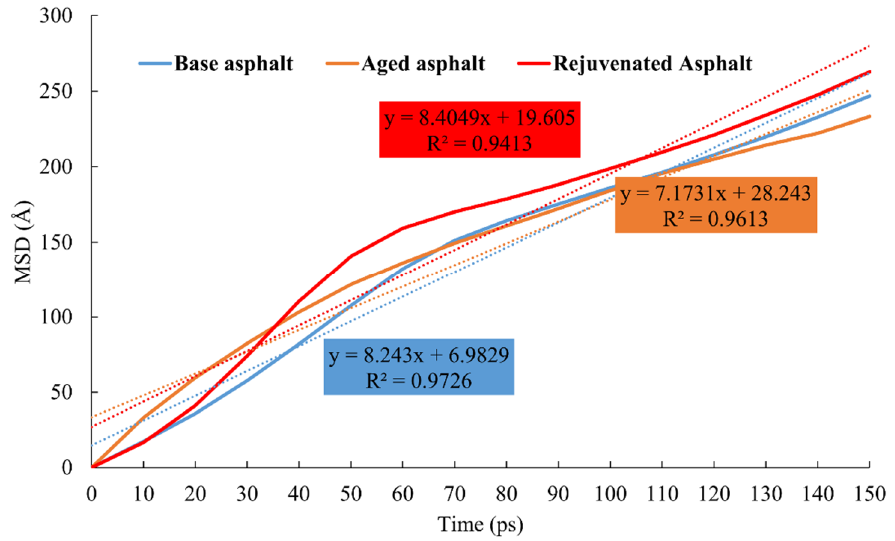
Figure 13. MSD results for asphalt.